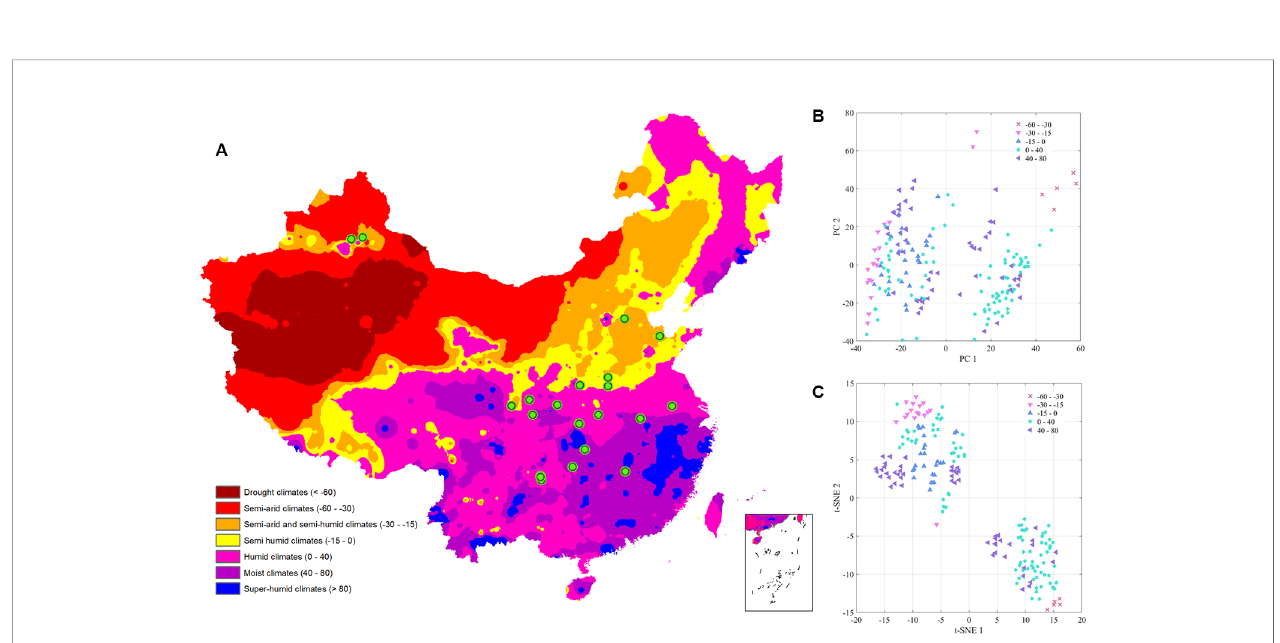
FIGURE 7 | The exploratory analysis results of Eucommia ulmoides leaves (EUL) samples in moisture index (A) : The distribution of each collection site; (B) : PCA; (C) :